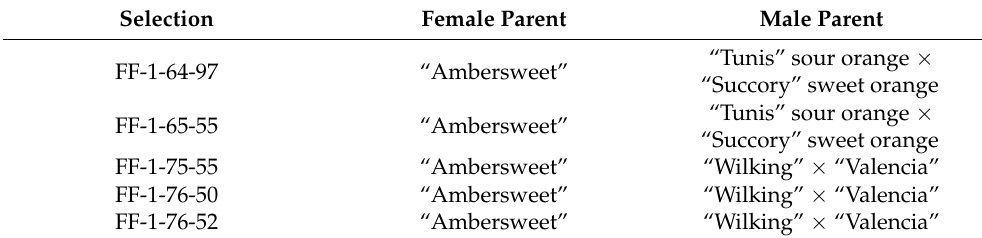
Table 3. Sweet-orange-like hybrids from the USDA citrus scion breeding program. Selection Female